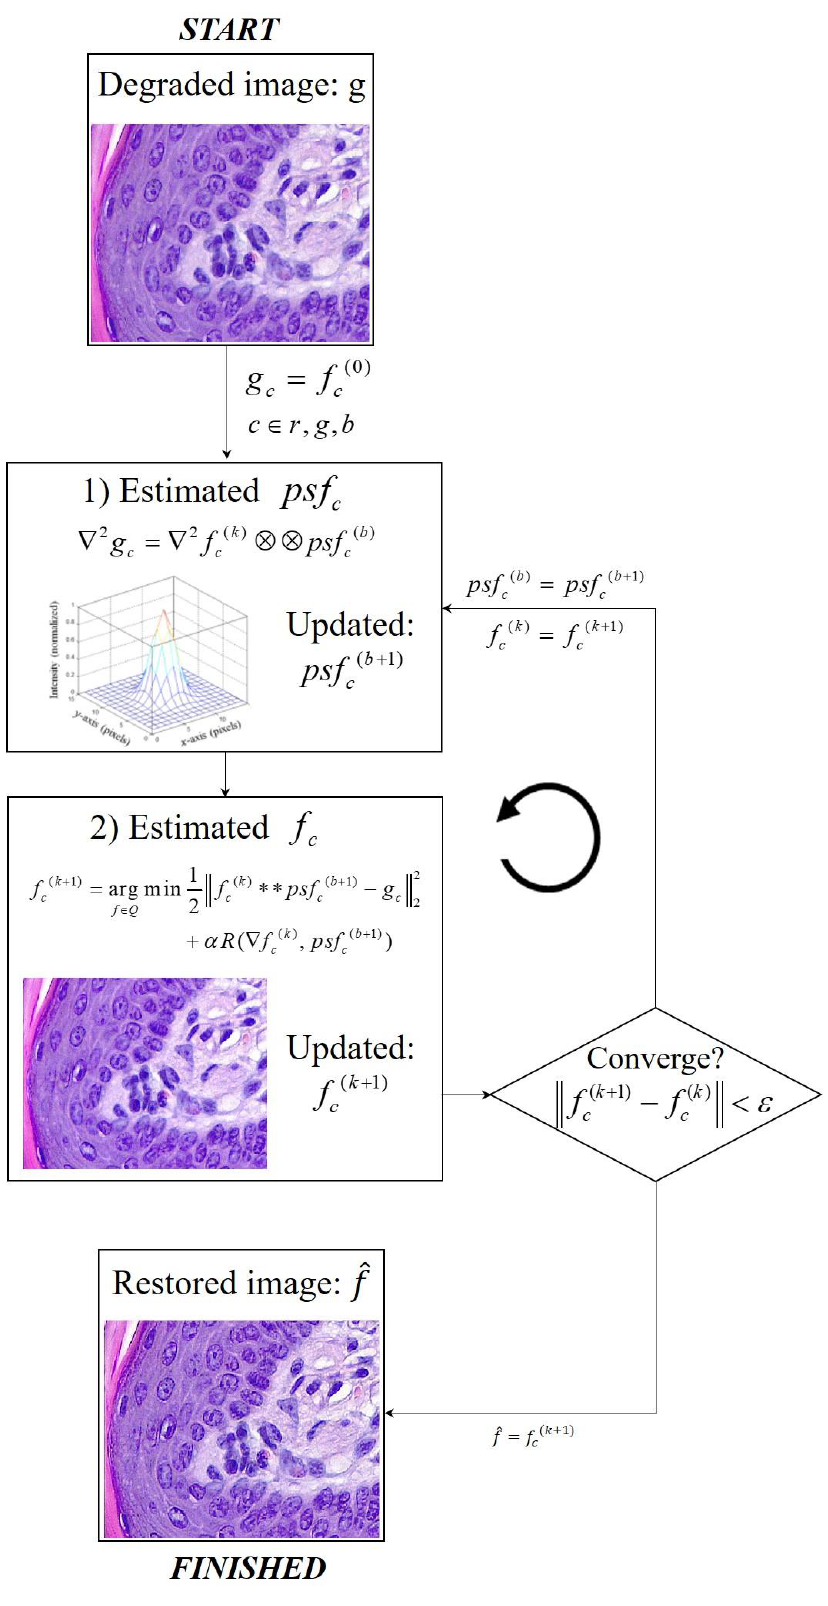
Figure 1. Flowchart of the blind deconvolution using the proposed method with the bi- l 0 - l 2 -norm regularization of the light microscopy image.